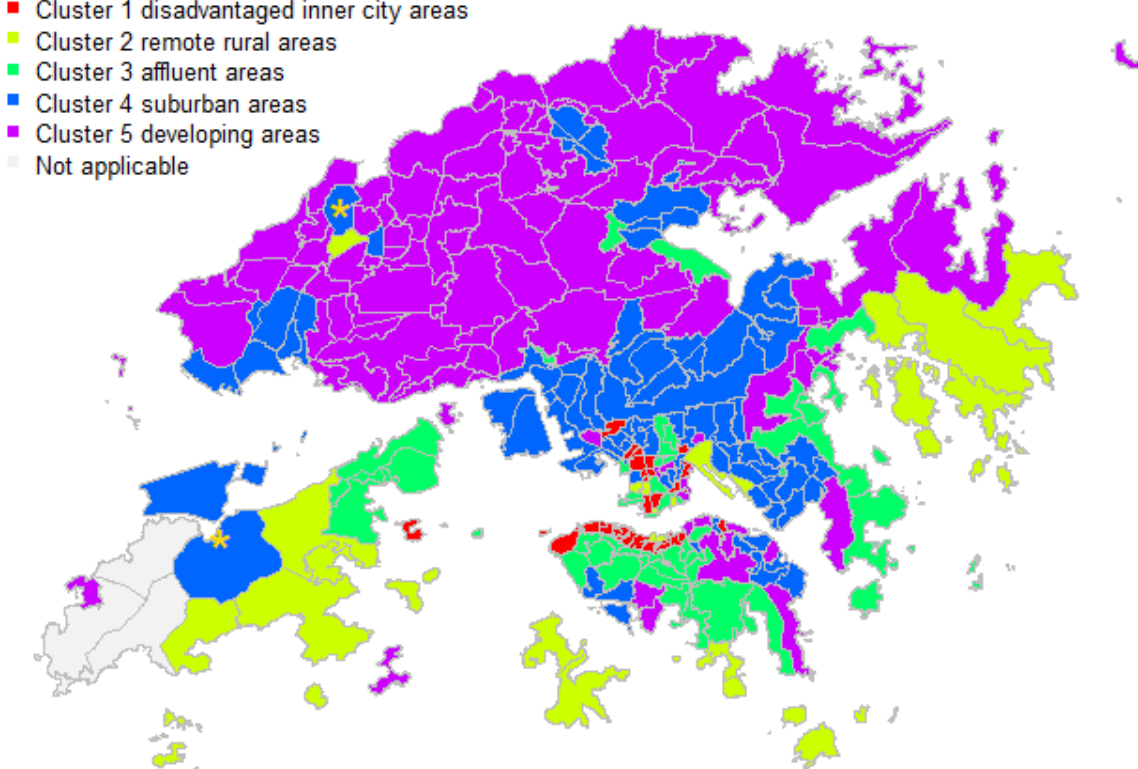
Figure 5. The five-cluster solution. Note: Two outliers were identified using gold asterisks, with Mahalanobis squared distance of 3.89 and 4.00, exceeding the critical value of 3. Both of these were in Cluster 4. Areas in grey located in southwest corner were the sub-region being excluded in the analysis.